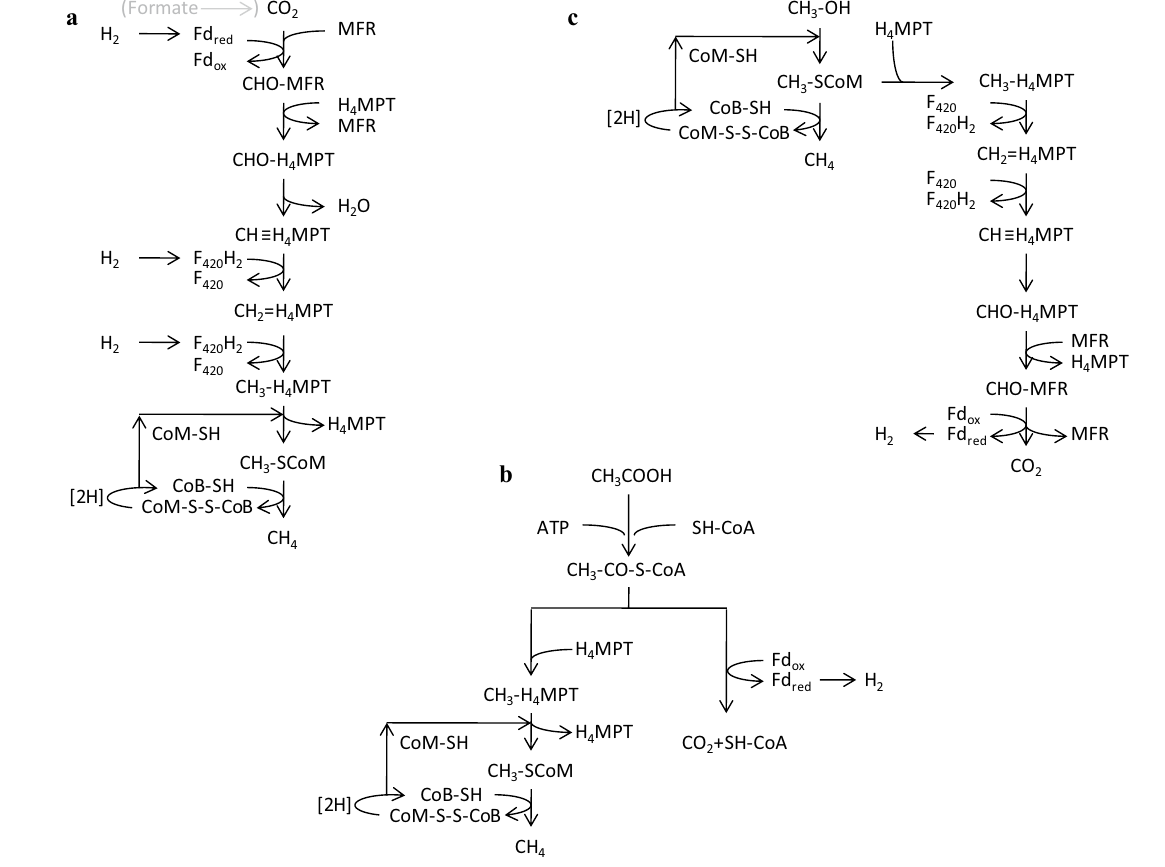
Fig. 1 Schematic overview of hydrogenotrophic ( a ), aceticlastic ( b ) and methylotrophic ( c ) methanogenesis. Hydrogenotrophic methanogenesis for Ech‑containing methanogens is shown. The methylotrophic methanogenesis from methanol is displayed. Abbreviations are mentioned in the text (Adapted from (Thauer et al. 2008; Welte and Deppenmeier 2014; Welander and Metcalf,